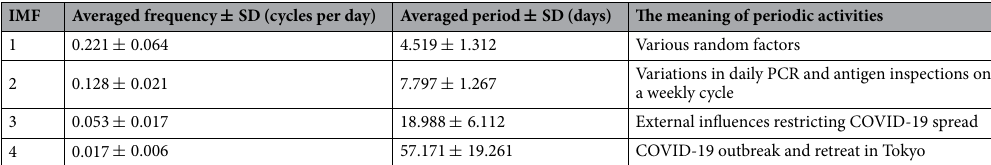
Table 1. The average frequencies and periods of each decomposed IMF by WAFA and their periodic meanings.